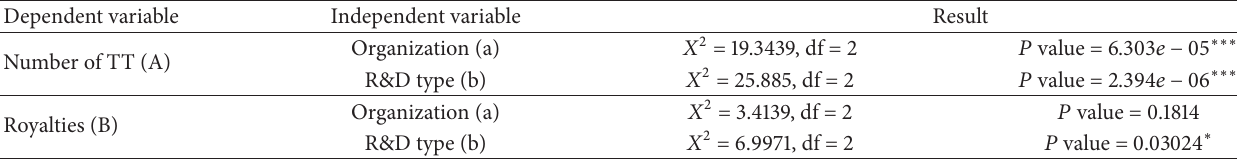
Table 5: Kruskal-Wallis test.